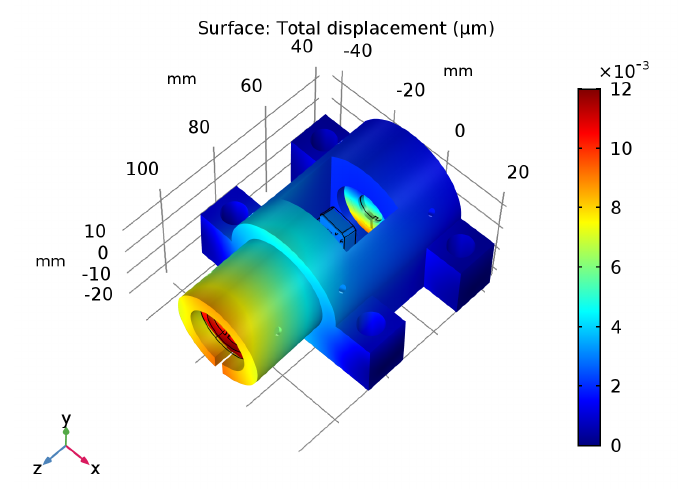
Figure 6. Displacement of the ECDL under action of gravitational